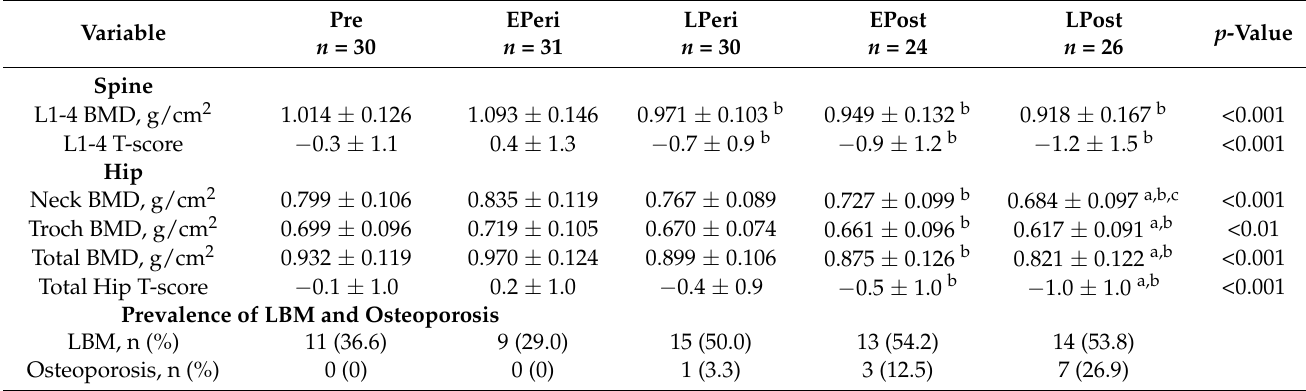
Table 2. Spine and hip bone